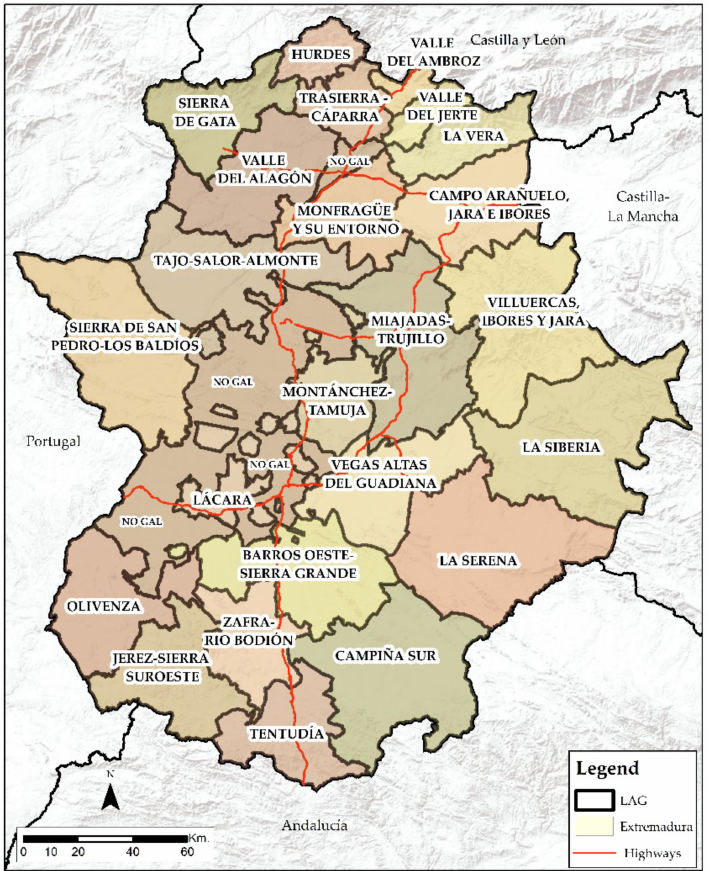
Figure 1. Local Action